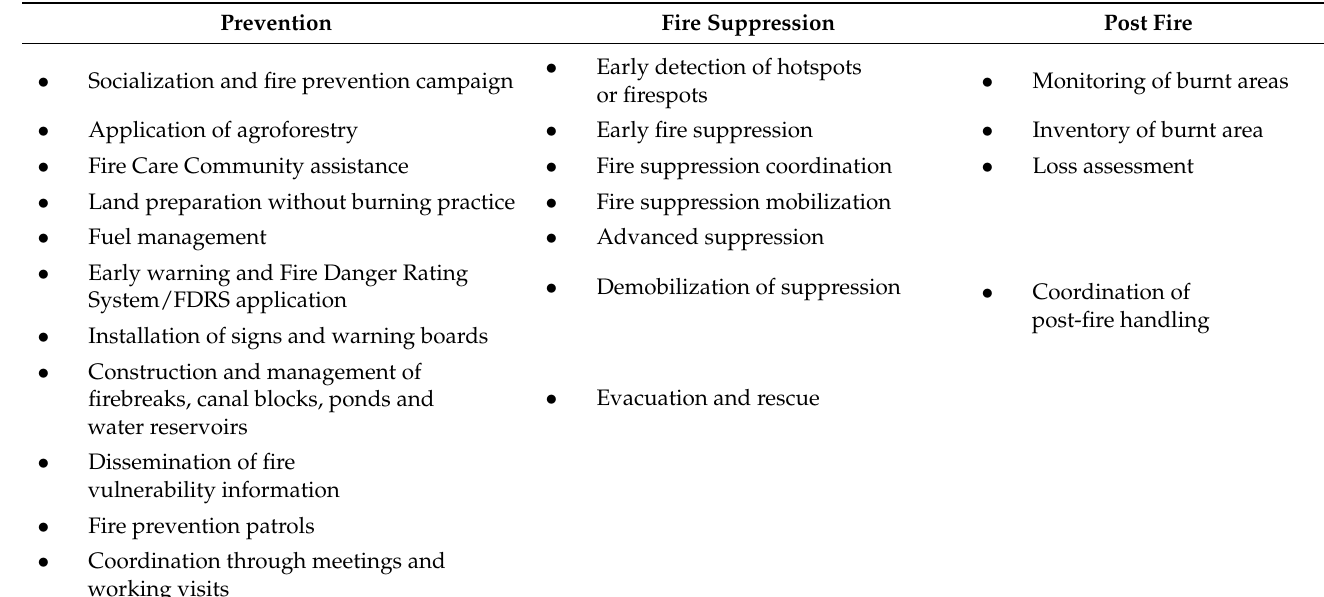
Table 2. Forest and Land Fire Control Activities by FMUs based on MoEF Regulation No.